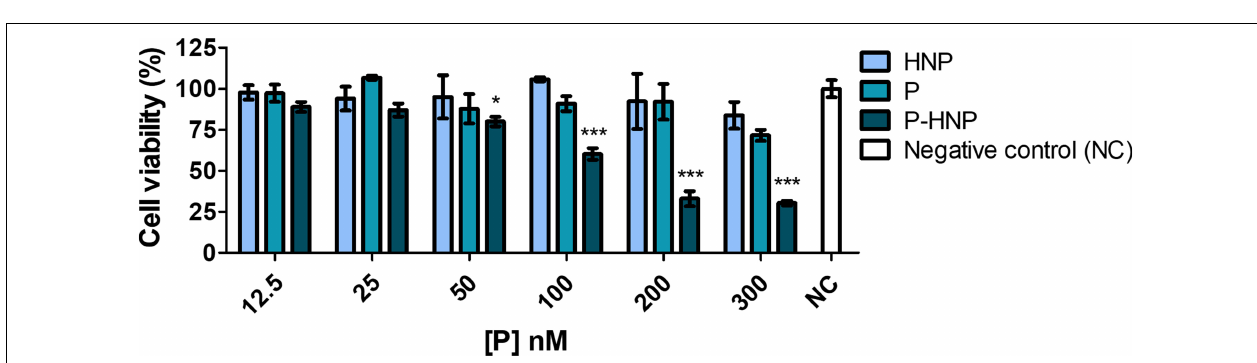
FIGURE 6 | Phototoxicity of free porphyrin ( P ) and porphyrin immobilized on hybrid nanoparticles ( P-HNP ) in T24 cells evaluated by resazurin after 6 h of treatment followed by photoinduction with a dose of 10 J/cm 2 . Negative control (NC)-untreated cells (cells + RPMI medium). The results are presented as mean ± SD of three independent experiments performed in triplicate. Significant differences relative to P and P-HNP , in each photoinduction dose, are indicated with an asterisk. Statistical significance: *** p < 0.001, * p < 0.05. Data obtained by two-way ANOVA analysis followed by Bonferroni